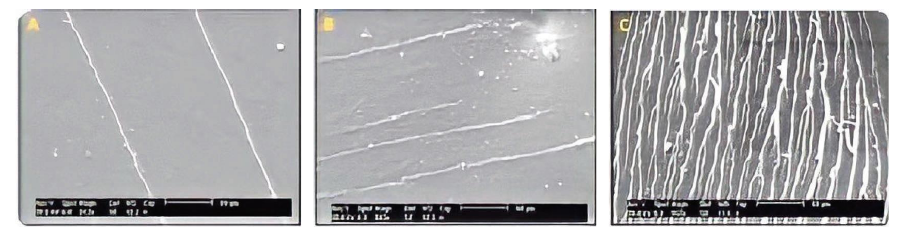
Figure 6: Microstructure of neat epoxy, epoxy +1% Al